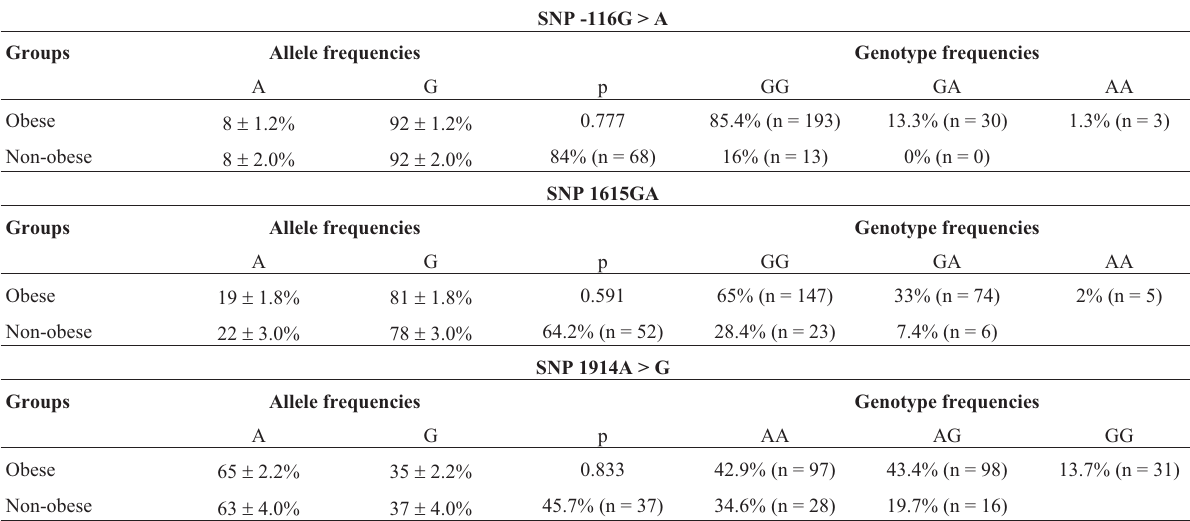
Table 1 - Comparisons of allele frequencies (p) and genotype distribution of -116G > A, 1615AG and 1914A > G SNPs (mean % (cid:3) standard error) in obese and non-obese